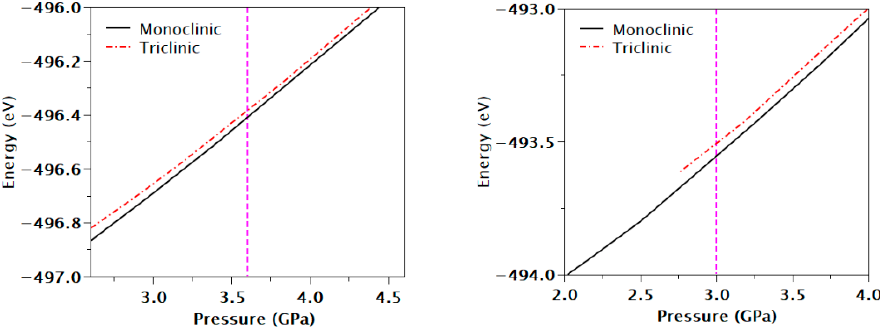
Figure 7. Energy curves of DFT simulations for [(CuBr) 2 (Quin)] ( left ) and [(CuI) 2 (Quin)] ( right ) considering monoclinic or triclinic phases.